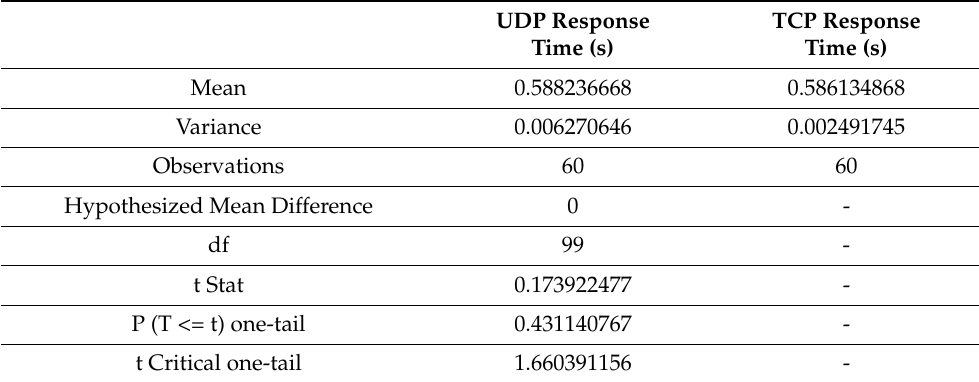
Table 3. Results from an independent sample t -Test.